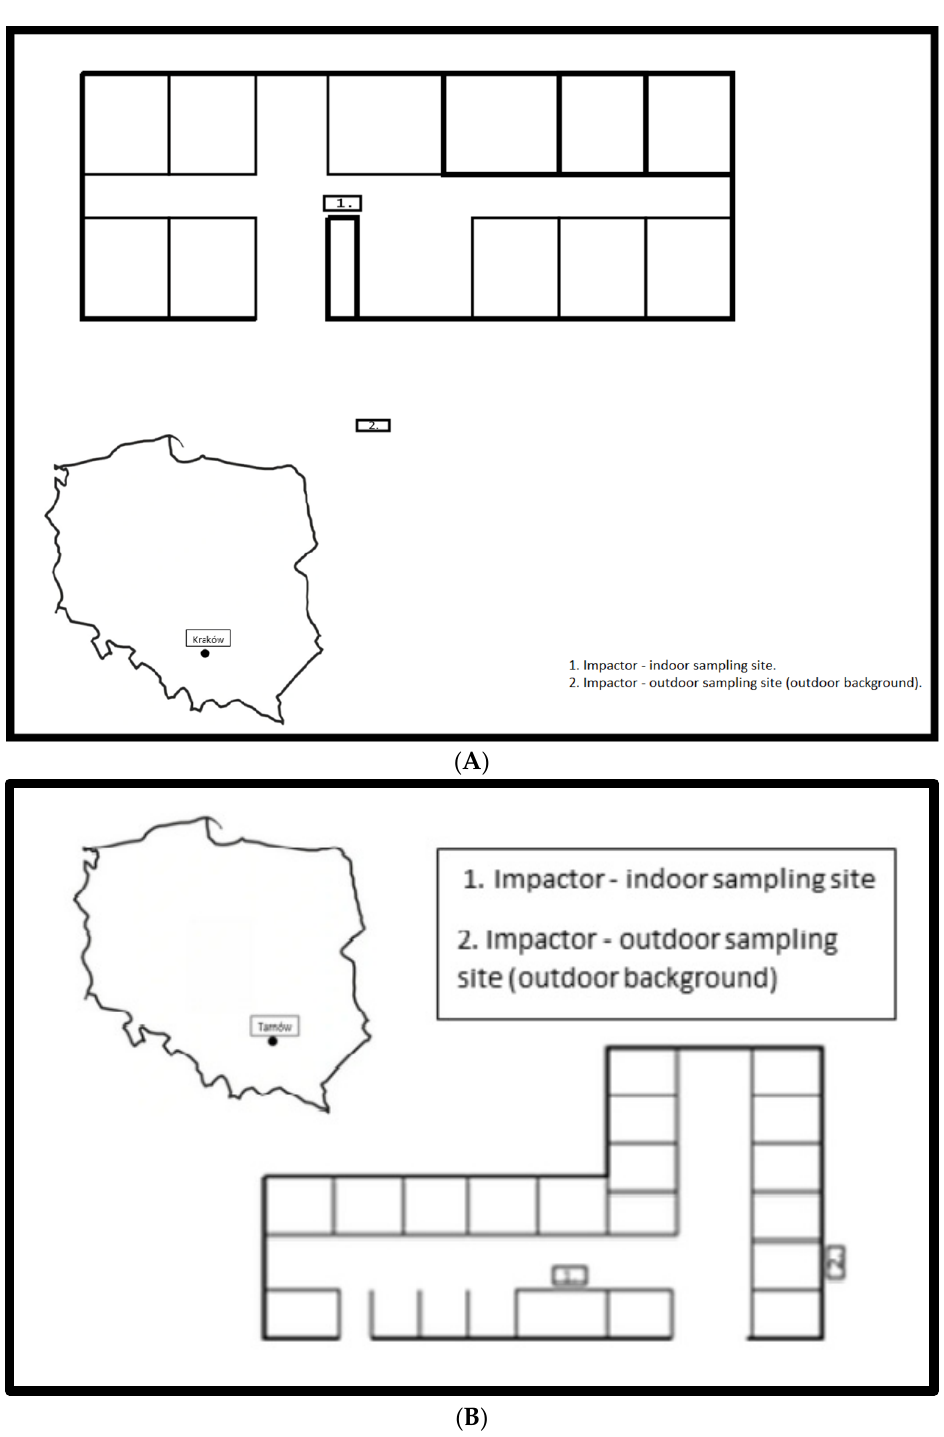
Figure 1. ( A ). Location and schematic presentation of the Kraków stable. ( B ). Location and schematic presentation of the Tarnów stable.